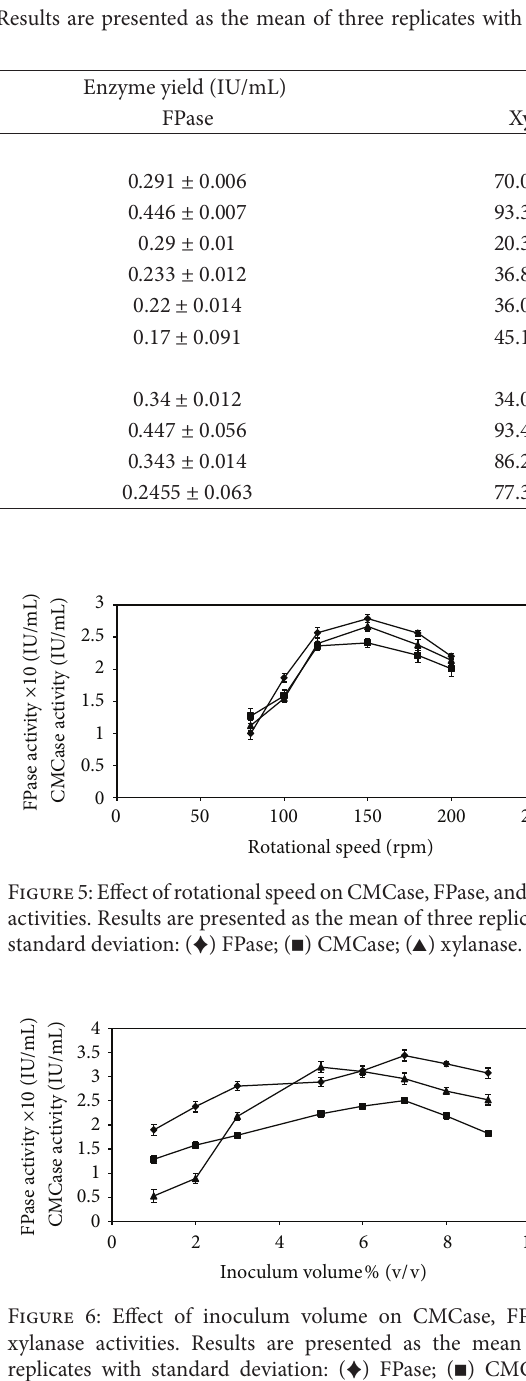
(Figure 7). After optimum level the enzyme production started to reduce probably due to catabolic